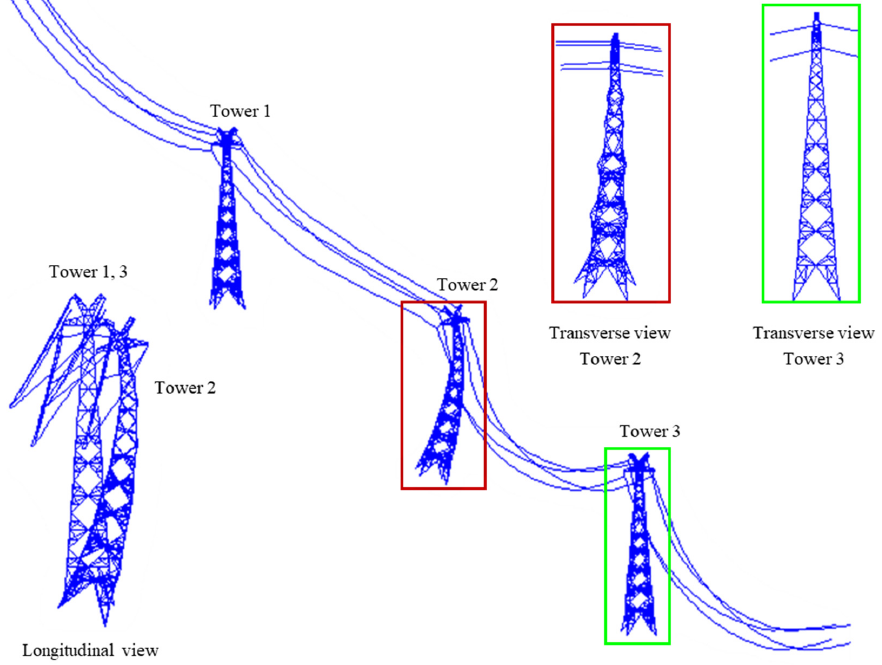
Figure 16. Behavior of the transmission tower-line structure at t = 9 s under Case 2.